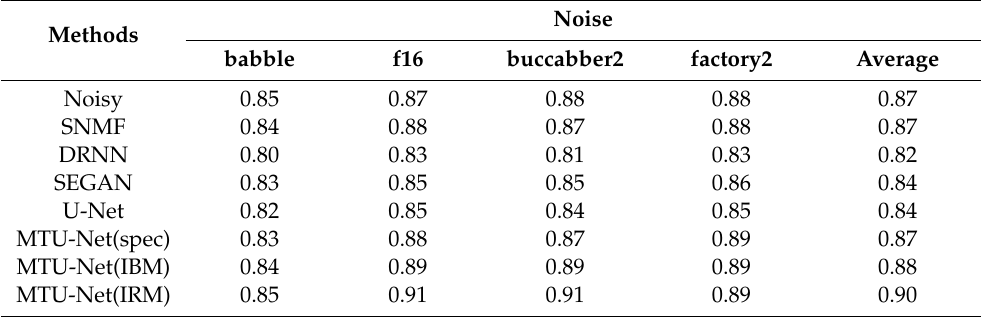
Table 3. Comparison of the short-time objective intelligibility (STOI) scores of seven di ff erent speech enhancement methods applied to the mismatched evaluation